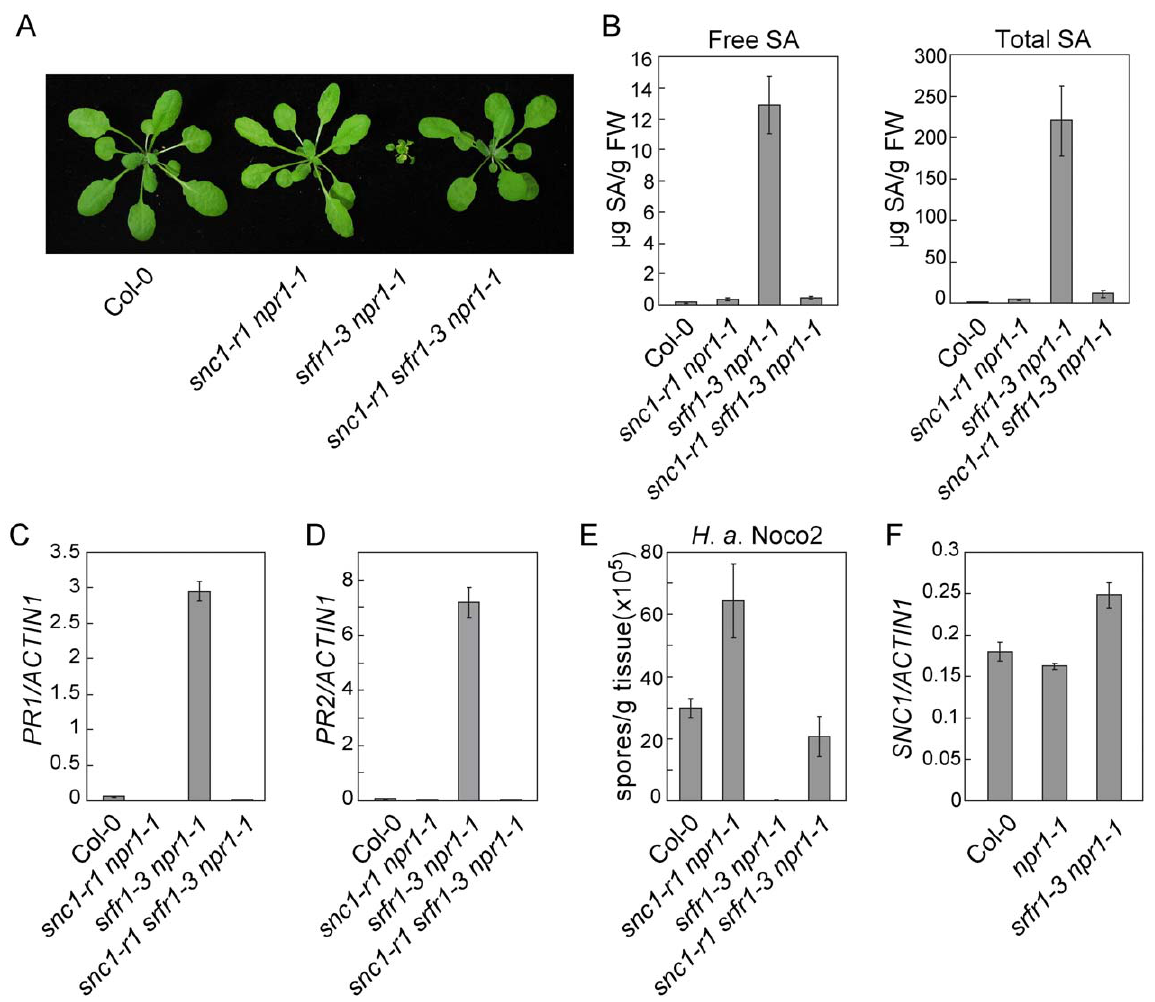
Figure 3. Loss of SNC1 function suppresses constitutive defense responses in snc5-1 / srfr1-3 . (A) Morphology of wild type (Col-0), snc1-r1 npr1-1 , srfr1-3 npr1-1 and snc1-r1 srfr1-3 npr1-1 plants grown on soil. The picture was taken when the plants were four weeks old. (B) Free and total SA in wild type (Col-0), snc1-r1 npr1-1 , srfr1-3 npr1-1 and snc1-r1 srfr1-3 npr1-1 . Error bars represent standard deviation from four measurements. (C–D) Expression levels of PR1 (C) and PR2 (D) in wild type (Col-0), snc1-r1 npr1-1 , srfr1-3 npr1-1 and snc1-r1 srfr1-3 npr1-1 compared to Actin1 . Error bars represent standard deviation from three measurements. (E) Growth of H. a. Noco2 on wild type (Col-0), snc1-r1 npr1-1 , srfr1-3 npr1-1 and snc1-r1 srfr1- 3 npr1-1 . Error bars represent standard deviation from three measurements. (F) Expression levels of SNC1 in wild type (Col-0), npr1-1 and srfr1-3 npr1-1 determined by q-RT-PCR. Error bars represent standard deviation from three measurements.